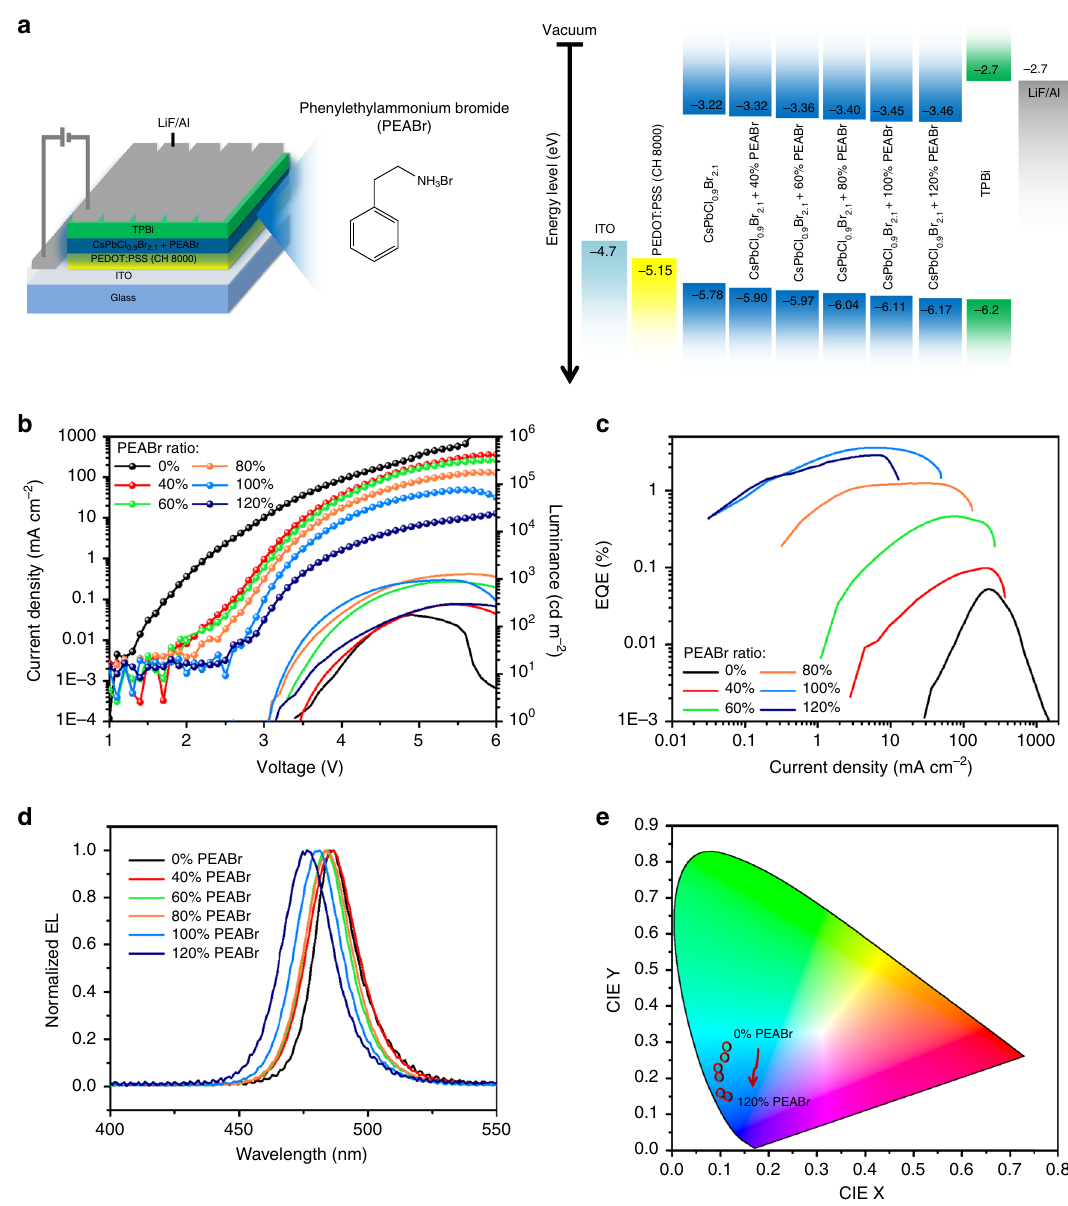
Fig. 3 Performance of CsPbCl 0.9 Br 2.1 perovskite light-emitting diodes (LEDs) with different ratios of phenylethylammonium bromide (PEABr). a Perovskite LED architecture and energy level diagram for different layers of the device. b Characterization of current density and luminance versus voltage. The solid lines and lines with dots correspond to the luminance and the current density, respectively. c Characterization of external quantum ef fi ciency (EQE) versus